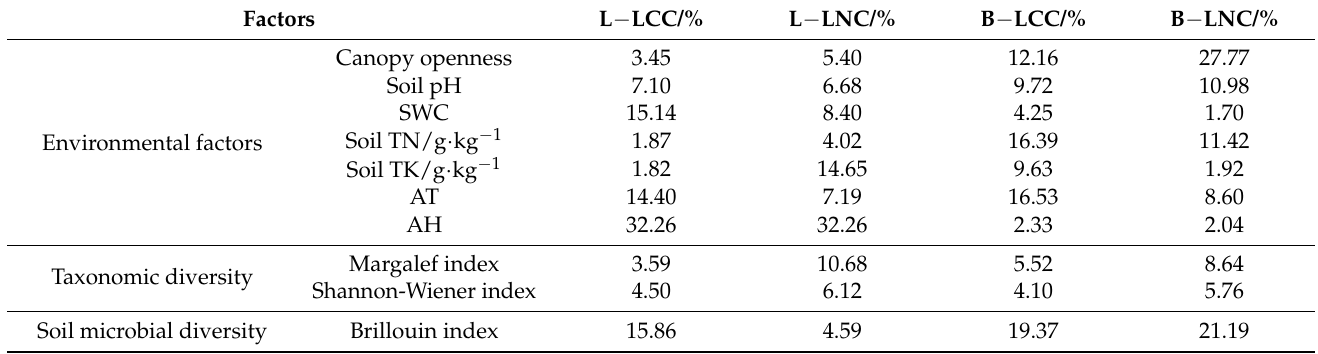
Table A7. The explanatory variables for factors in litter nutrient release at the early decomposition stage.